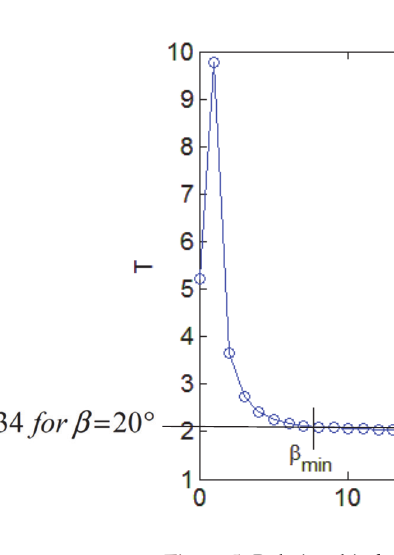
Figure 5: Relationship between scatter values T and the angle β for